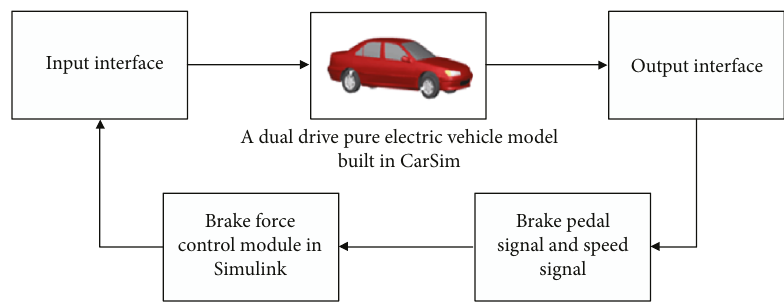
Figure 3: Mechanism diagram of simulation control combined with CarSim and Simulink.